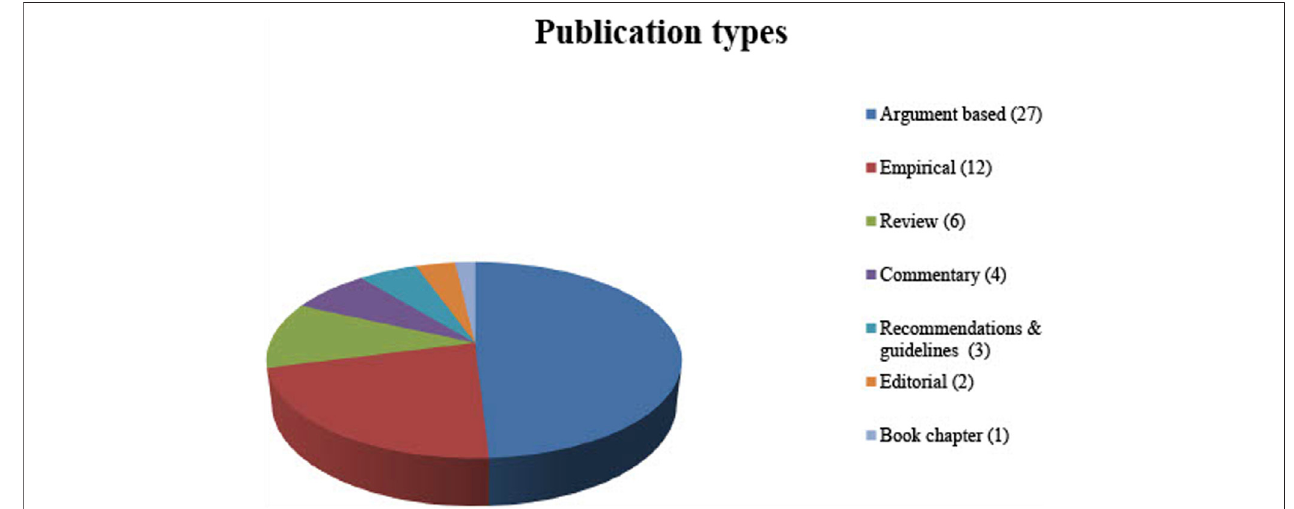
FIGURE 2 | Publication